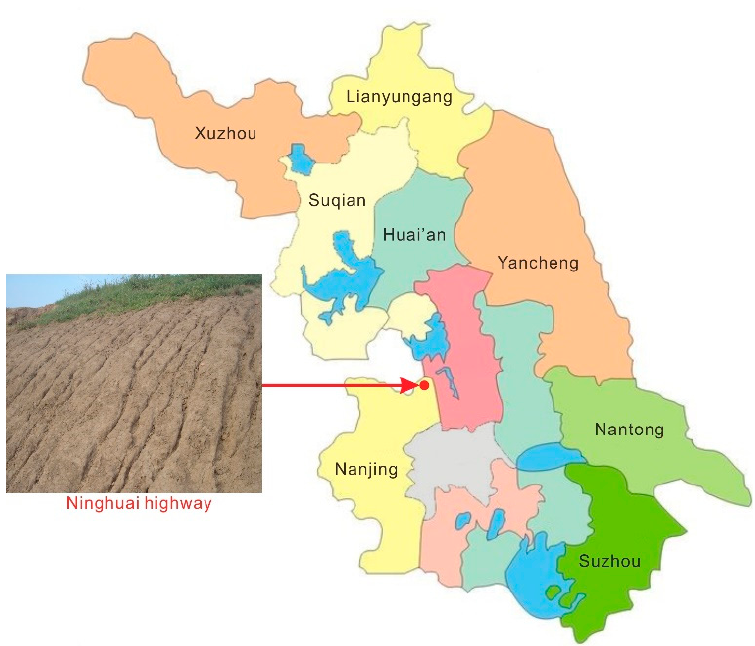
Figure 9. The location of the field tests in Jiangsu Province, China.